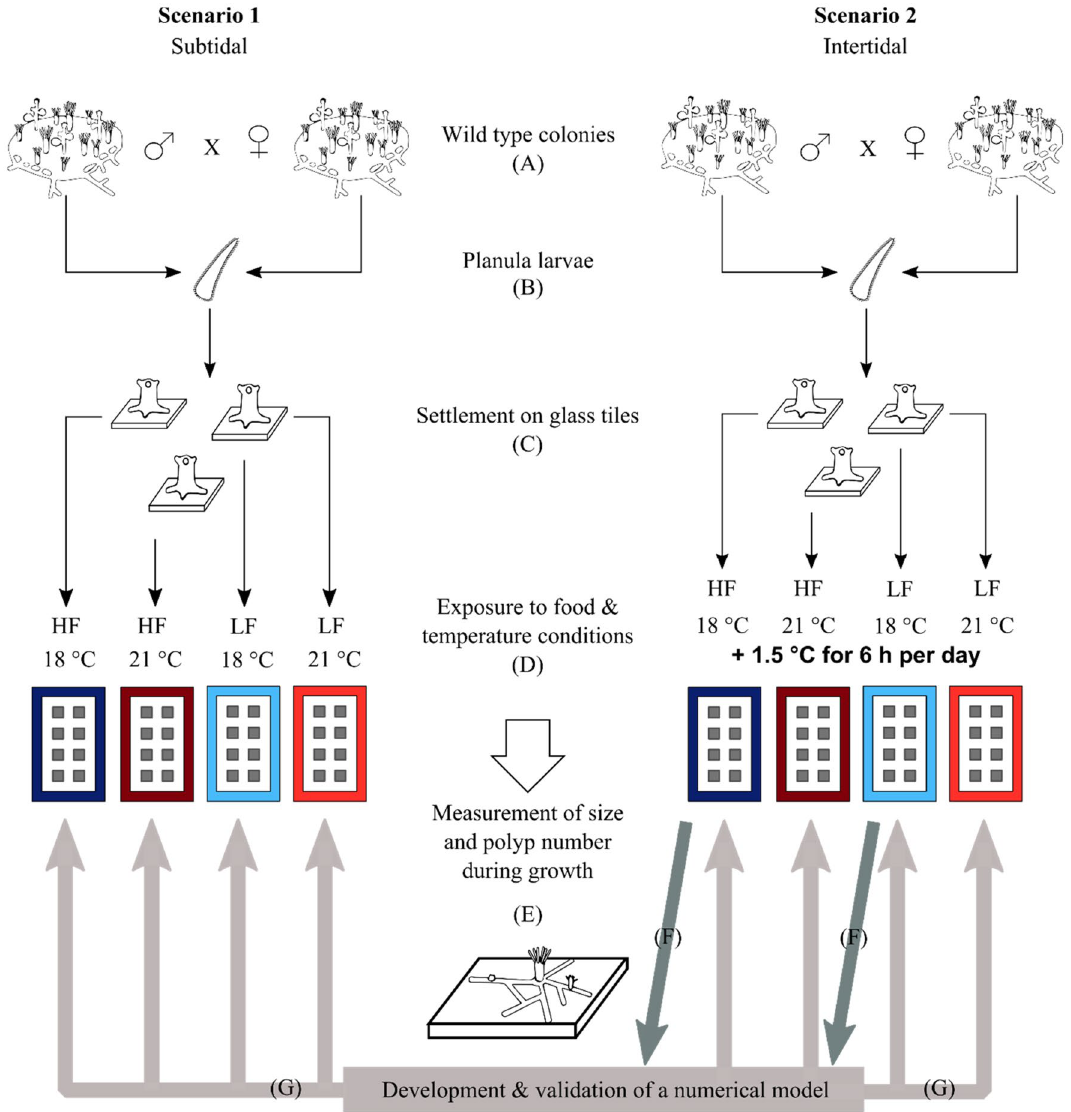
Figure 7. Experimental design for analysing growth performance and mortality of juvenile H. echinata in two experiments, scenario 1 (left) and 2 (right). The larvae ( b ) of wild type colonies ( a ) were settled on glass tiles ( c ) and transferred to holding tanks for experimental exposure to variable temperature and food conditions ( d ): HF = high food (dark blue and red tanks); LF = low food (light blue and red tanks); 18 °C = control temperature (blue tanks); 21 °C = high temperature (red tanks). All treatments in scenario 2 contained an extra temperature step of + 1.5 °C for six hours daily. Throughout the experimental timeline and in each treatment, the growth performance of H. echinata was monitored ( e ). Additionally, a numerical growth model was developed ( f dark grey arrows) based on daily analysis of morphological parameters (colony area, polyp number) in hydroids in treatments HF/18 °C and LF/18 °C of scenario 2 and validated ( g light grey arrows) by comparing simulated and experimental growth data in all treatments of both